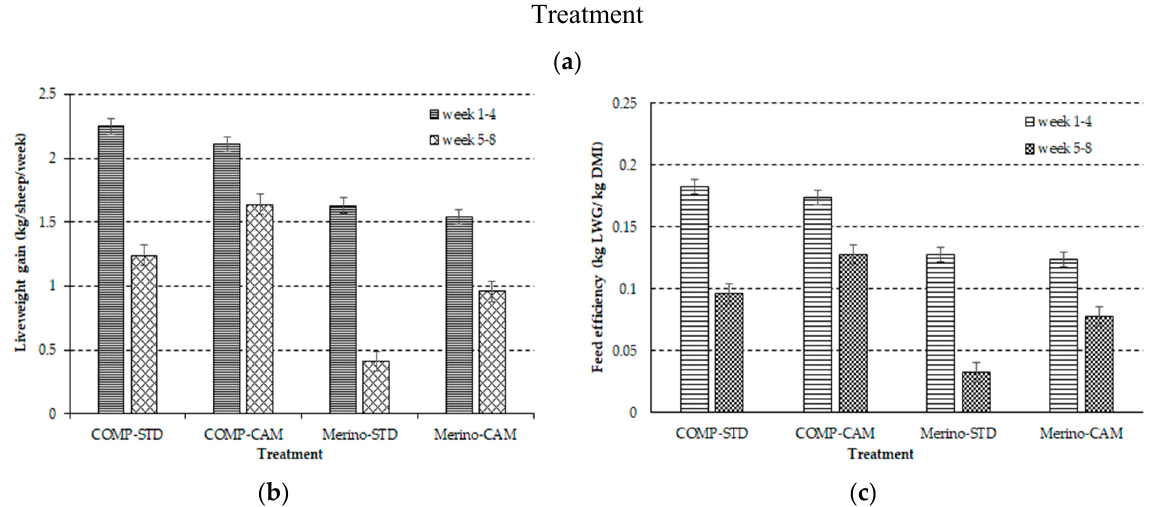
Figure 4. Overall ( a ) and weekly ( b ) average liveweight gain for Composite (COMP) lambs and Merino yearlings fed standard forage mixture diet (STD) or camelina forage mixture diet (CAM) during weeks 1–4 and weeks 5–8. Feed efficiency (kg LWG/kg DMI) for maternal Composite (COMP) lambs and Merino yearlings fed standard forage mixture diet (STD) or camelina forage mixture diet (CAM) during weeks 1–4 and weeks 5–8, respectively ( c ).